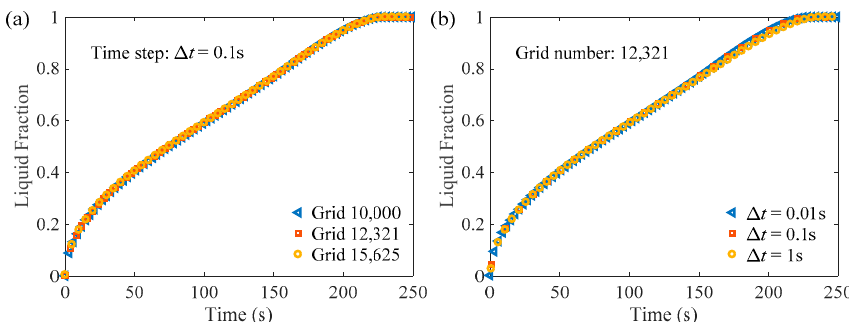
Figure 2. Grid and time step independency analysis: ( a ) grid independence study with a time step of 0.1 s; ( b ) time step independence study with a grid number of 12,321.